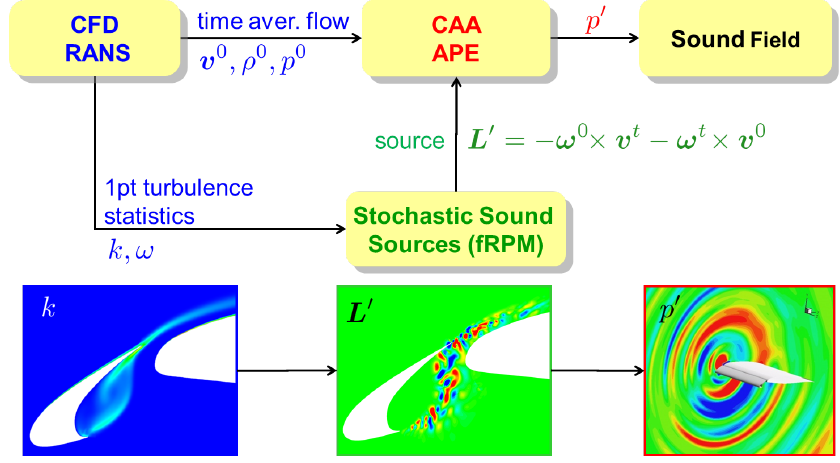
Figure 2. CAA component noise prediction concept, (see [14]) on the example of slat